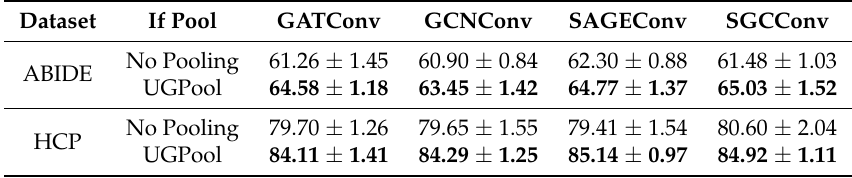
Table 5. Classification accuracy of brain connectivity with and without global UGPool architecture. Dataset If Pool